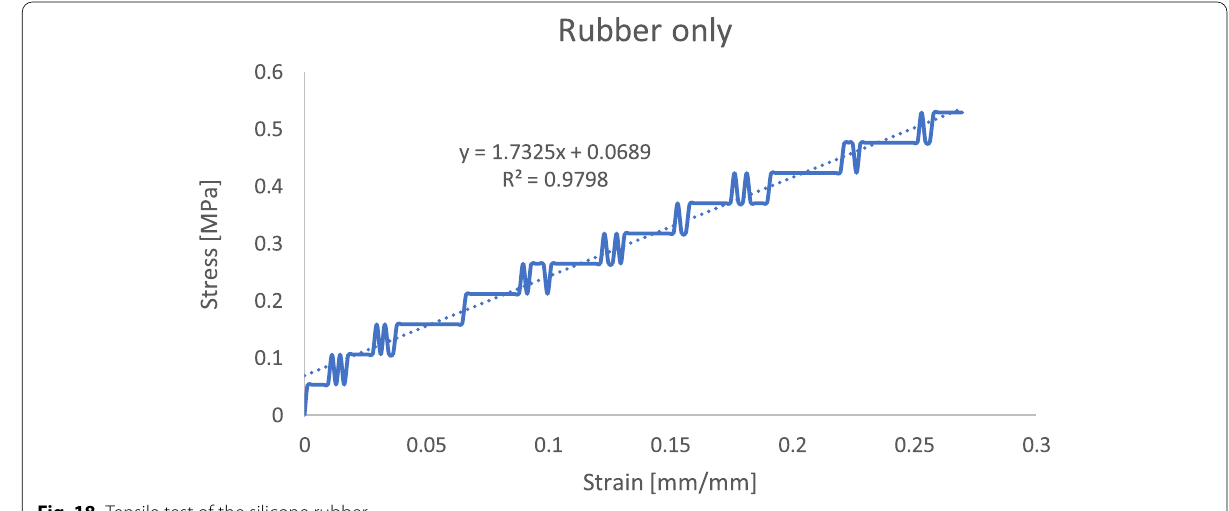
Fig. 18 Tensile test of the silicone